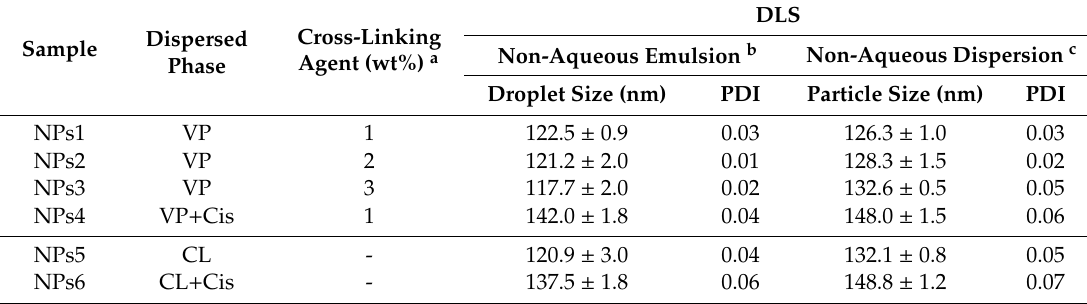
Table 1. Droplet and particle sizes as well as the PDI values for both non-aqueous emulsions